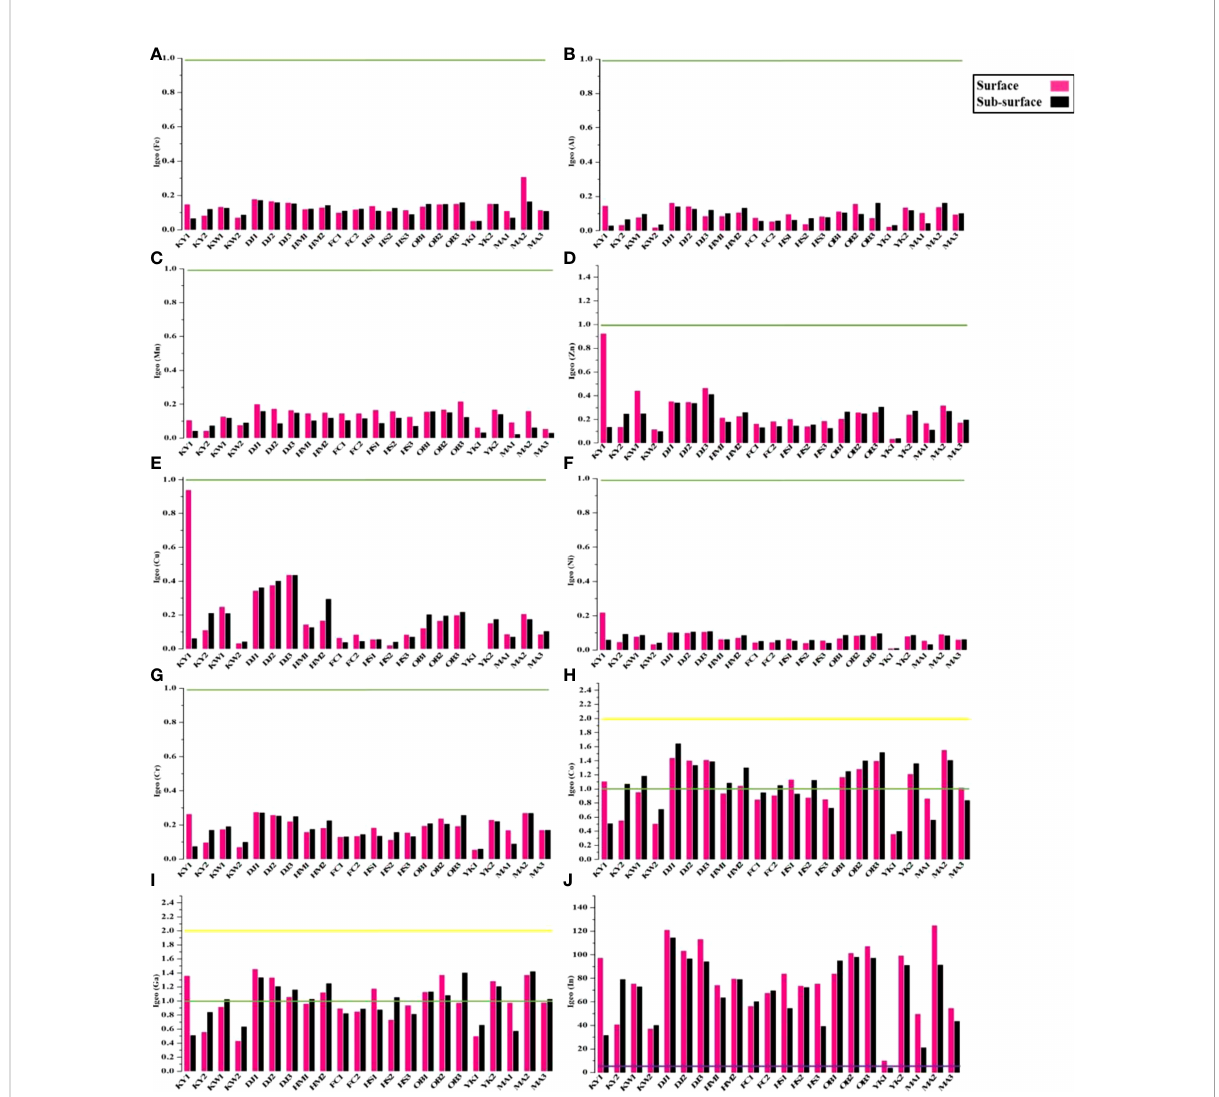
FIGURE 5 Geo-accumulation index (I geo ) with pollution degree for studied metals in surface and sub-surface sediments of Siangshan wetland. Green, yellow, and purple lines refer to classes 0, 1, and 5, respectively (Table